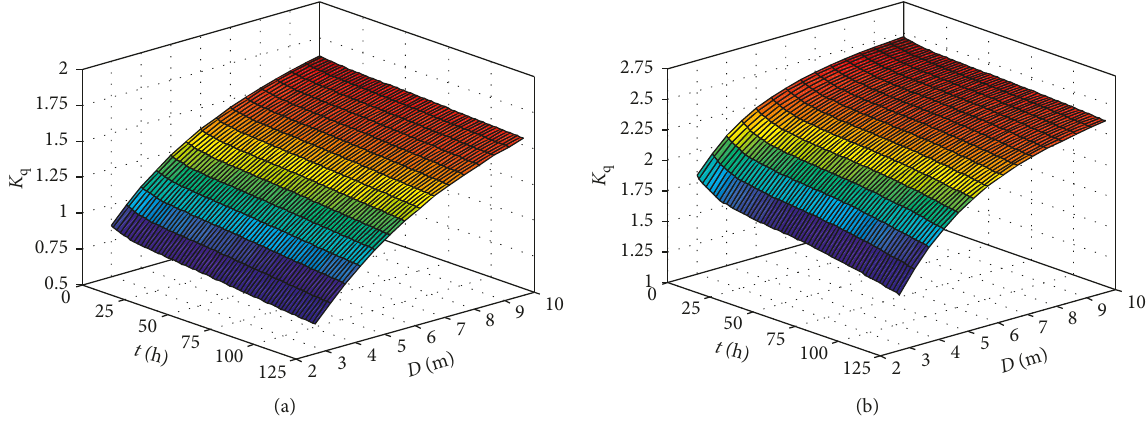
Figure 6: Variation of safety factor against overturning with embedded depth and time. (a) b